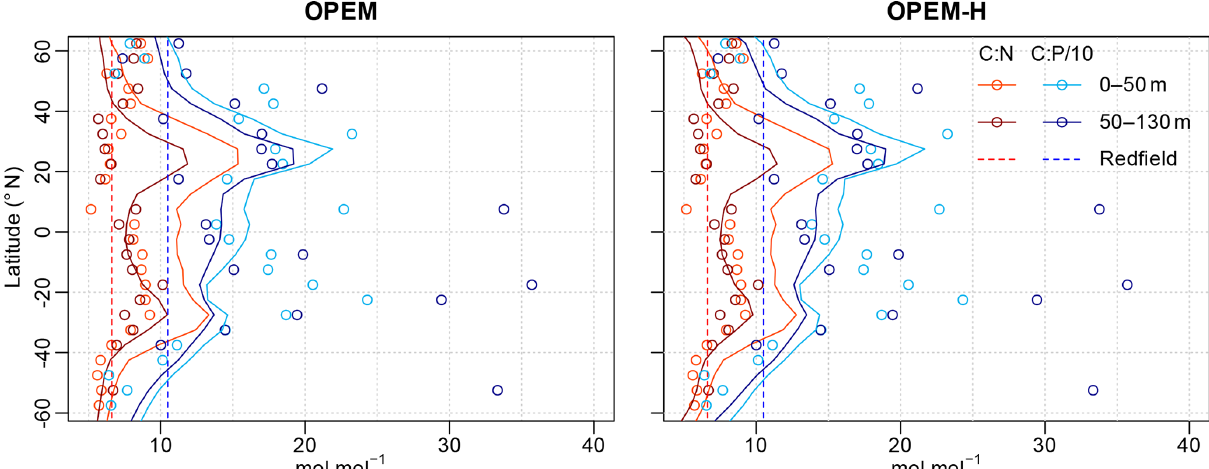
Figure 16. Zonally averaged particulate C : N and C : P ratios for the depth ranges of the two topmost layers of UVic for 5 ◦ latitude bands. Lines are predictions from the OPEM and OPEM-H simulations, and circles represent data from Martiny et al. (2014). POC < 0 . 01mmolm − 3 , PON < 1µmolm − 3 , and POP < 0 . 1µmolm − 3 were removed from the observations prior to calculating the ratios. Observed ratios were mapped onto the UVic grid by taking the median of all available data for each grid cell and then zonal log averages were calculated.